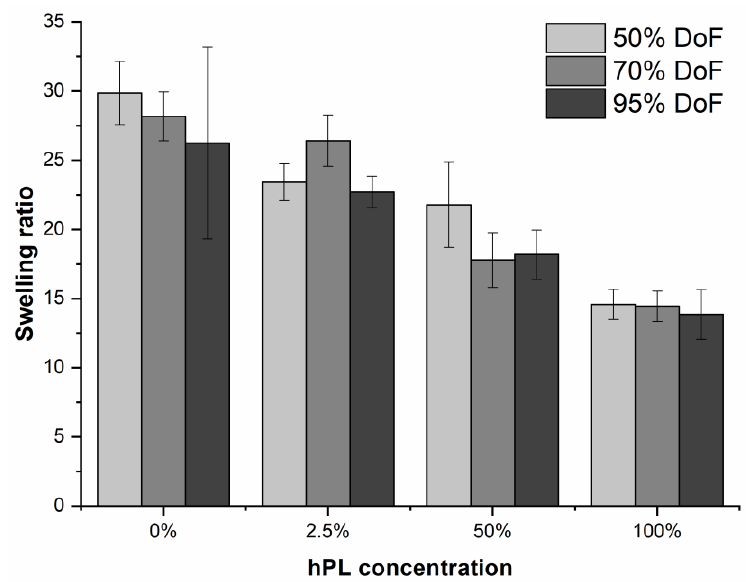
Figure 6. Swelling ratio of GelMA hydrogels with 50%, 70%, and 95% functionalization and the addition of 0%, 2.5%, 50%, and 100% hPL. Data represent the mean ± SD for a sixfold determination.